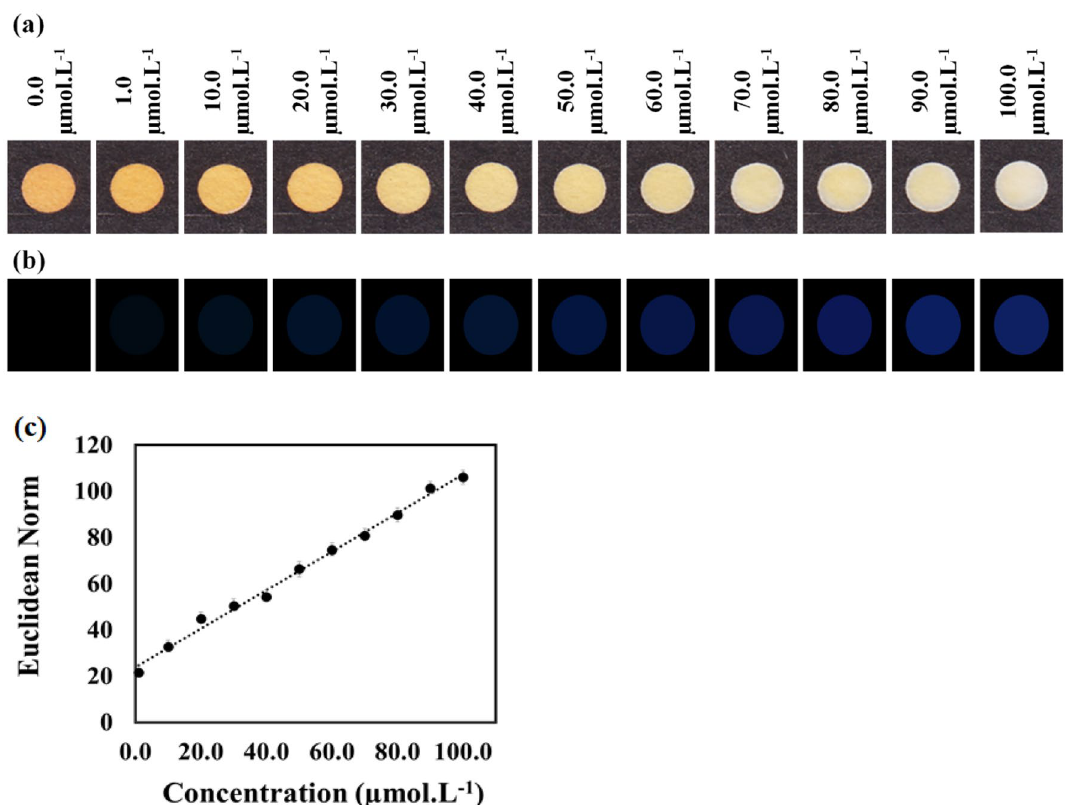
Figure 3. ( a ) The colorimetric responses, ( b ) the color difference maps and ( c ) the calibration curve for different concentration of cyanide ions. The study was performed in the presence of TCA (25.0% W/V), borate buffer (0.1 M, pH 10.0) and receptor (1.0 mg mL −1 ). 2.0 µL of analyte was injected and the image of sensor was captured after 25